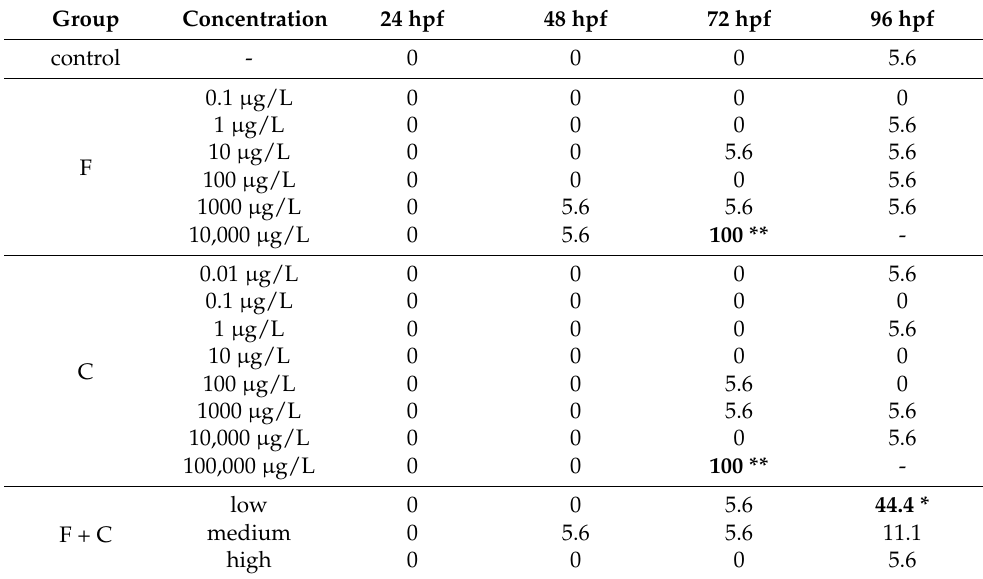
Table 2. Cumulative mortality (%) of African clawed frog embryos exposed to antidepressants as single substances and as a mixture. Bold font and the asterisks indicate a significant difference (* p < 0.05, ** p < 0.01) between the control and the experimental groups at the same time of